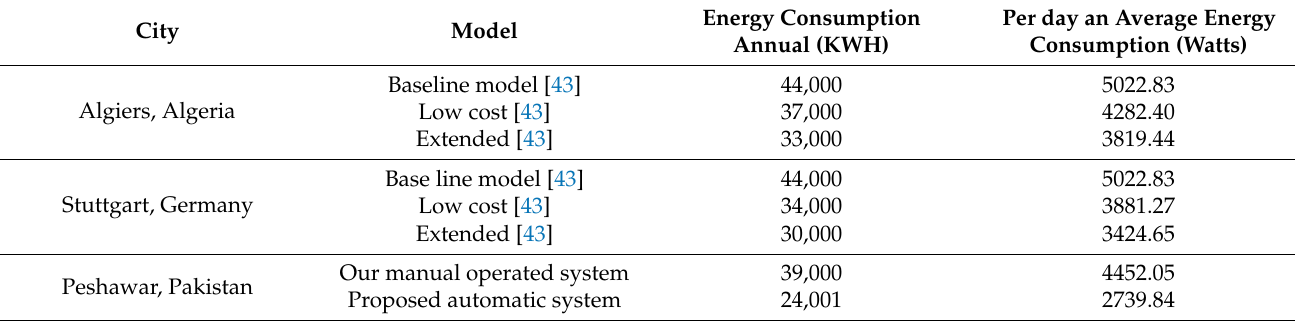
Table 1. Performance of the proposed system vs. state-of-the-art concerning energy consumption.